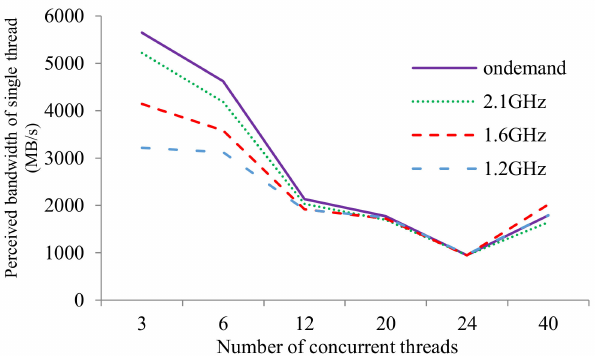
Figure 4. Average perceived bandwidth of single thread with array size = 4 GB (MB/s) on server #1.